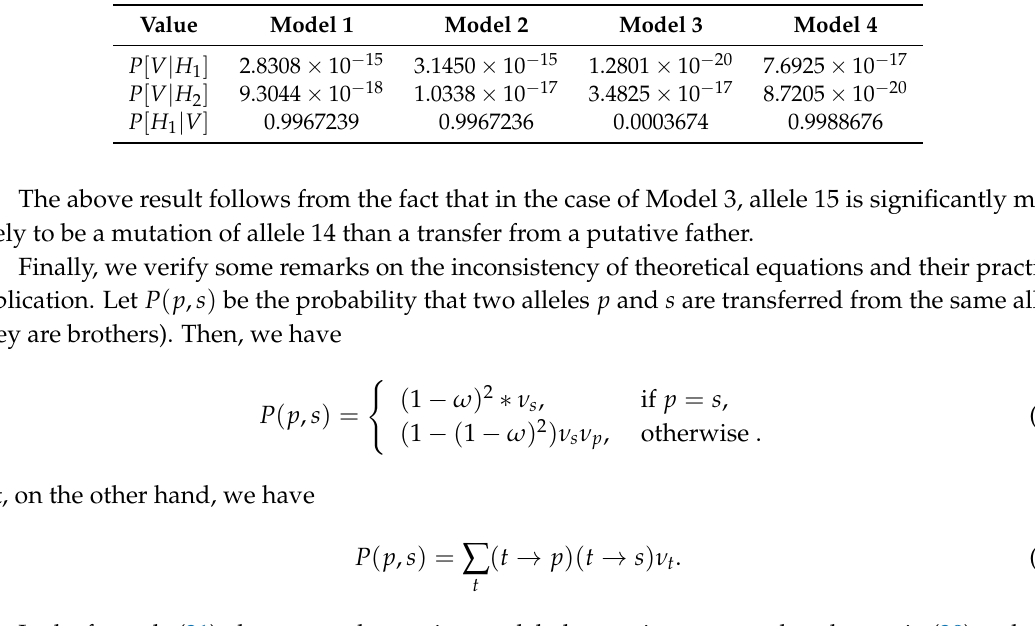
Table 3. Probability that we achieve DNA profiles V , providing man P is a father of D ( P [ V | H 1 ] ), probability that we achieve DNA profiles V , providing P is not a father of D ( P [ V | H 2 ] ), and probability that P is a father of D ( P [ H 1 | V ] ) in the case of ( P , D , M ) = (( 15,15 ) , ( 7,15 ) , ( 14,14 )) at locus